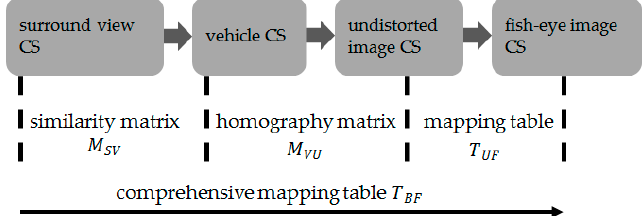
Figure 3. Surround view generation process.